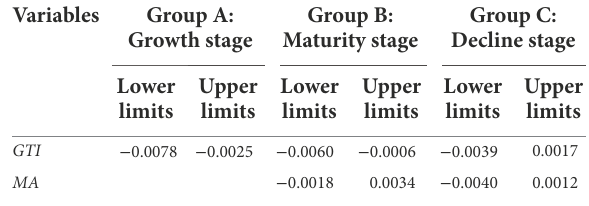
TABLE 8 Regression results of different life cycle stages. TABLE 9 Bootstrap test